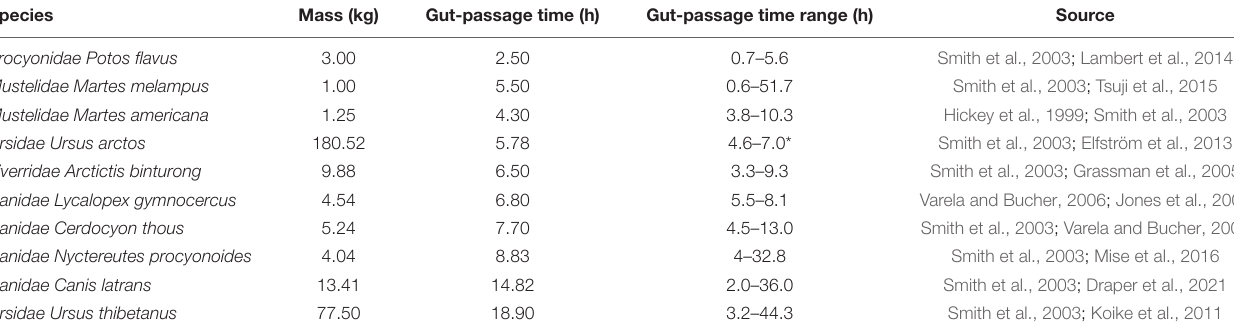
TABLE 2 | Animal body mass, average gut-passage time, and the range of gut-passage time of Carnivoran species identified as frugivores/seed dispersers. Species Mass (kg) Gut-passage time (h) Gut-passage time range (h)